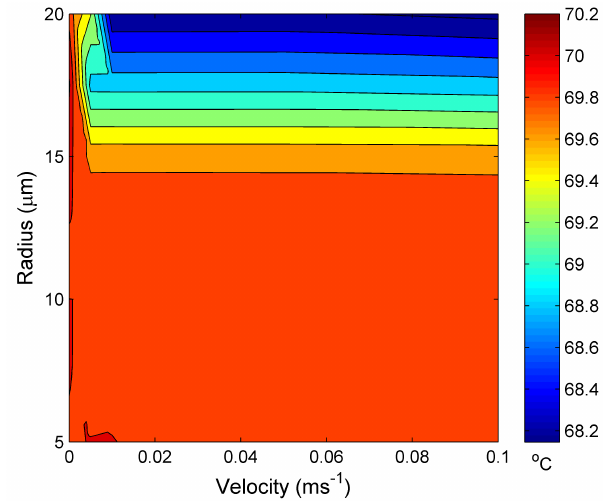
Figure 8. Calculated temperature at the steady state vs. the water hole radius and water input velocity at 60 ◦ C